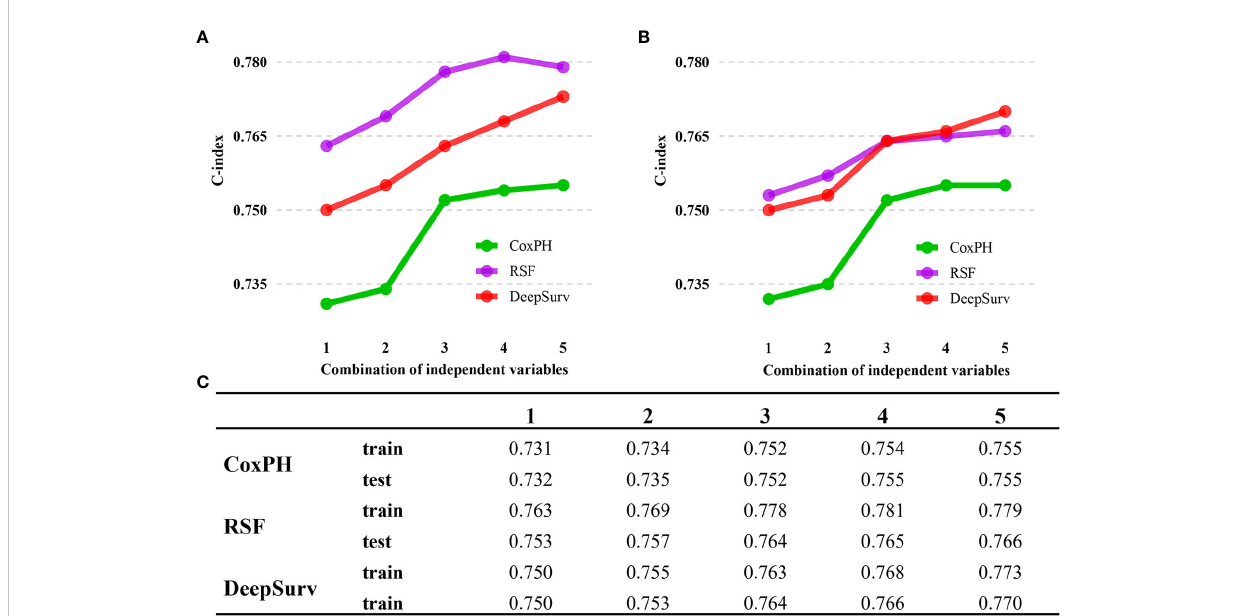
FIGURE 3 C-index performance of the DeepSurv, RSF, and COXPH models. (A) C-index performance on train cohort. (B) C-index performance on train cohort. (C) Summary of C-index for each models. DeepSurv fared the best of the three models, displaying a considerably more positive trend. The numbers 1 to 5 indicate the different variable compositions. The addition of statistically insigni fi cant factors is seen in Points 4 and 5. Point 1 indicates the Age, Race, Marital status, Summary Stage, T stage, M stage, Surgery of the primary site, regional nodes examined, regional nodes positive, Tumor bone metastasis, and Tumor size. Point 2 adds new variables, including Primary Site and Grade. Point 3 adds variable N stage, AJCC stage, and chemotherapy. Point 4 continues to add variables Months from diagnosis to treatment and sex. Point 5 then adds the remaining insigni fi cant variables from the cox